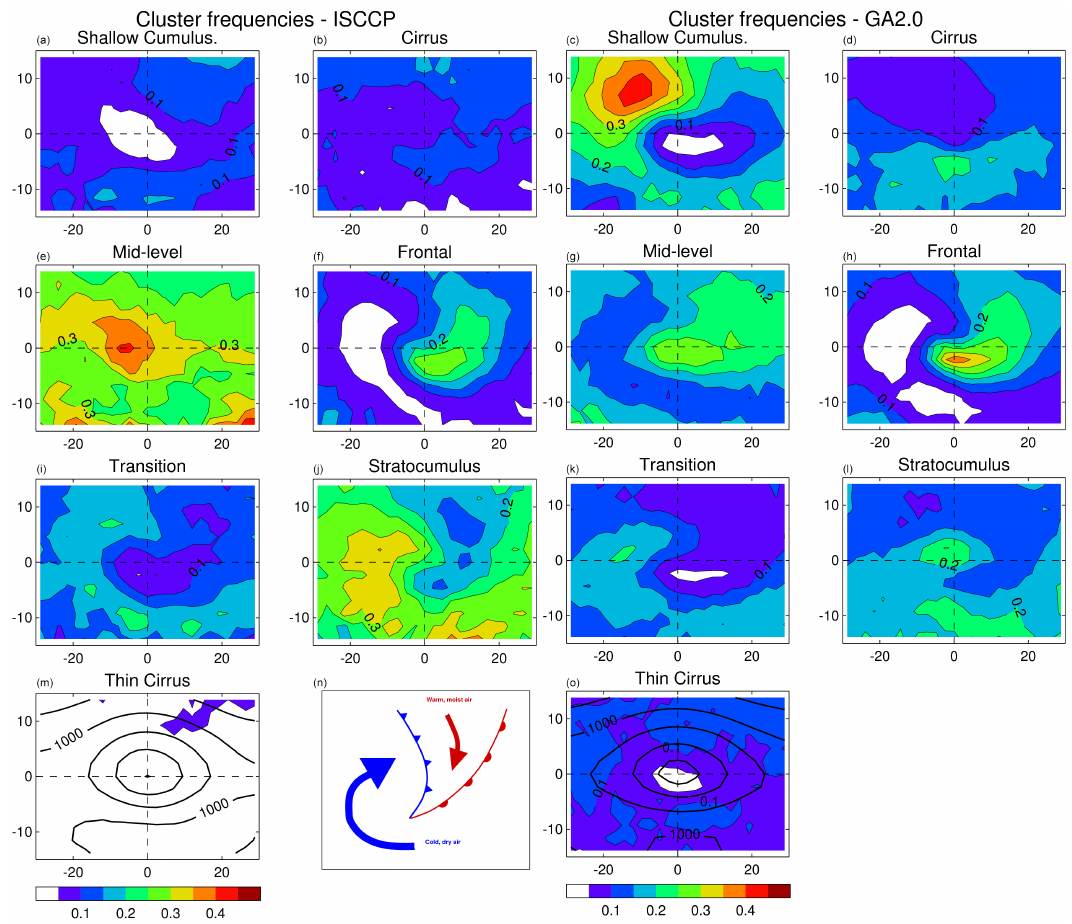
Figure 14. Relative frequency of occurrence of ISCCP-derived cloud regimes composited on a cyclone-centred reference framework (left) obtained from ERA-40 daily mean sea level pressure and (right) for a model (GA2.0’s) cloud regimes and mean sea level pressure. In (m) and (o) , the thick contours show the mean sea level pressure with 8hPa intervals. (n) in the left panel is a schematic with the typical position of the fronts in the cyclone composite. Reprinted from Bodas-Salcedo et al. (2012), ©American Meteorological Society. Used with